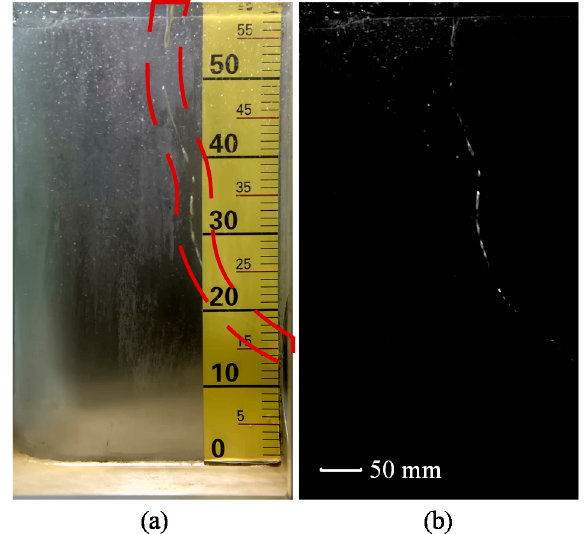
Figure 9. ( a , b ) level V free-surface and level V sub-surface vortices original results and the related gray recognition results, ( c , d ) original level VII free-surface and related gray recognition results in the primary pump intake.